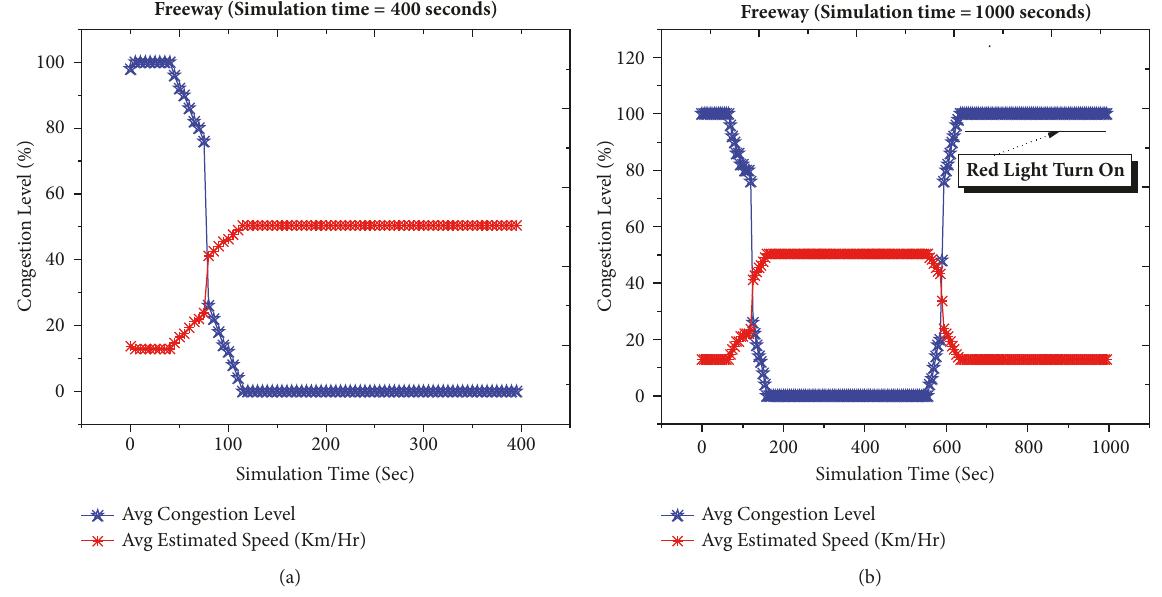
Figure 6: Temporal congestion detection and speed estimation in freeway, number of lanes = 2, DSRC Rang = 500m, car size = 5m, safety time threshold = 2 sec, maximum speed = 50Km/h, total numbers of vehicles = 50, and road